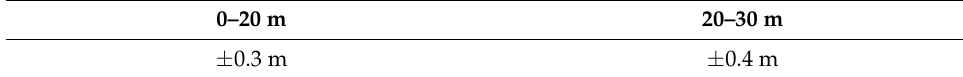
Table 5. Error limits of the position error of sounding positioning point.